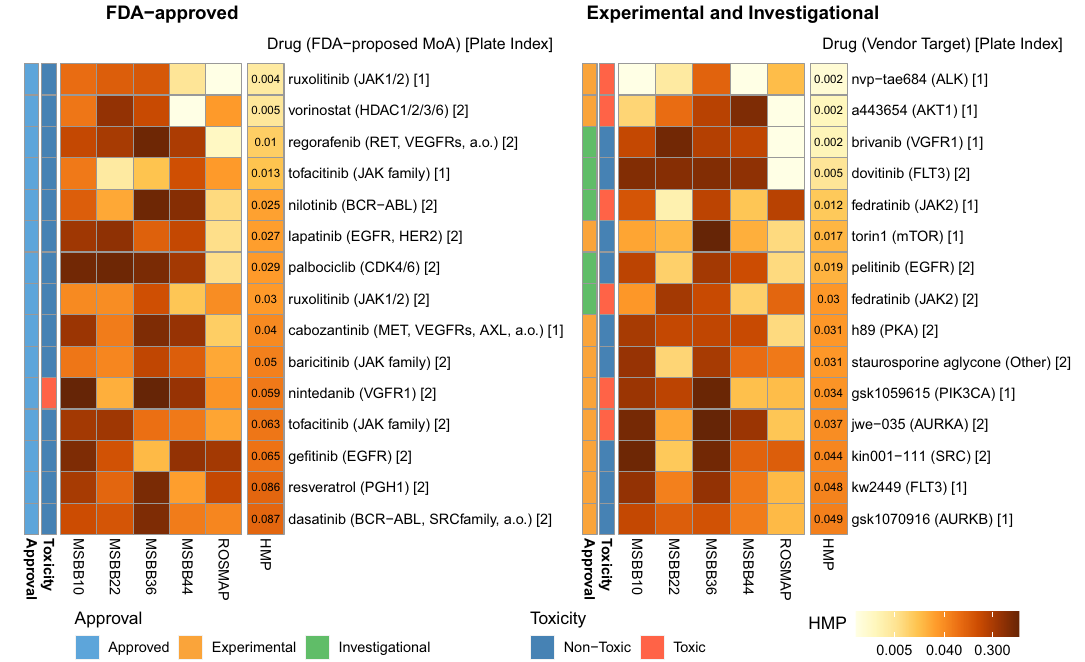
Fig. 3 Top 15 FDA-approved (left) and experimental/investigational (right) drugs, sorted by harmonic mean p -value. Each heatmap shows unadjusted empirical p -values associated with a drug ’ s predictive performance across two AMP-AD datasets, ROSMAP and MSBB. The MSBB analysis is further subdivided by the brain region, speci fi ed as Brodmann Area. The empirical p -values were computed by counting the proportion of randomly selected lists that outperformed the gene lists of interest (i.e., a one-sided test). The p -values were then aggregated across the datasets by computing the harmonic mean p -value (HMP), which is shown in the last column of each heatmap. The rows are annotated with the name of the drug/compound, its nominal target, and the index of the corresponding DGE experiment. Additional annotations include information about each compound ’ s approval status (approved/investigational/experimental) and whether compounds were found to be toxic in neuronal cell